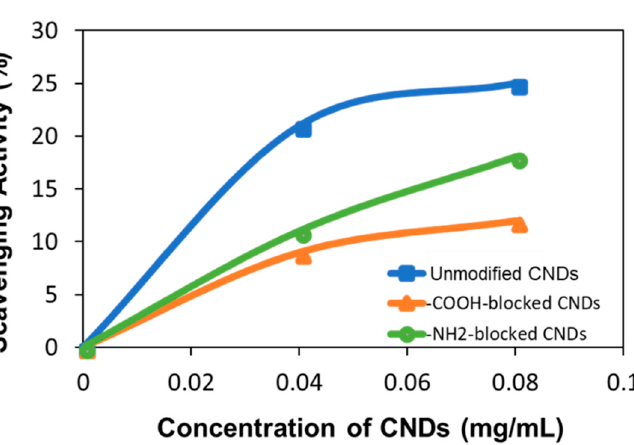
Figure 5. The tendency of the averaged DPPH • scavenging activity of the three types of CNDs as a function of concentration. The standard deviation of the data points is listed in Table 1.